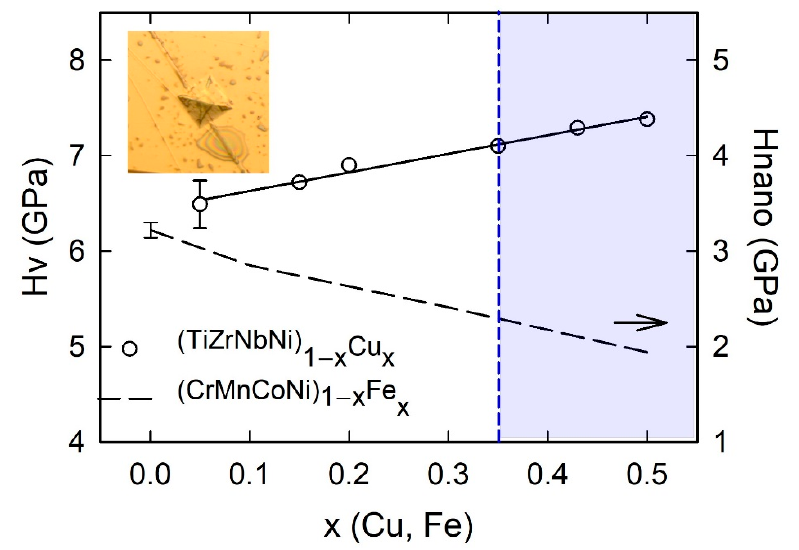
Figure 18. Room temperature Vickers microhardness, H V , of (TiZrNbNi) 1 − x Cu x MGs and nanohard- ness, H nano , (dashed line) of (CrMnCoNi) 1 − x Fe x alloys vs. x . The inset: the image of a typical indenta- tion on the surface of an MG sample.